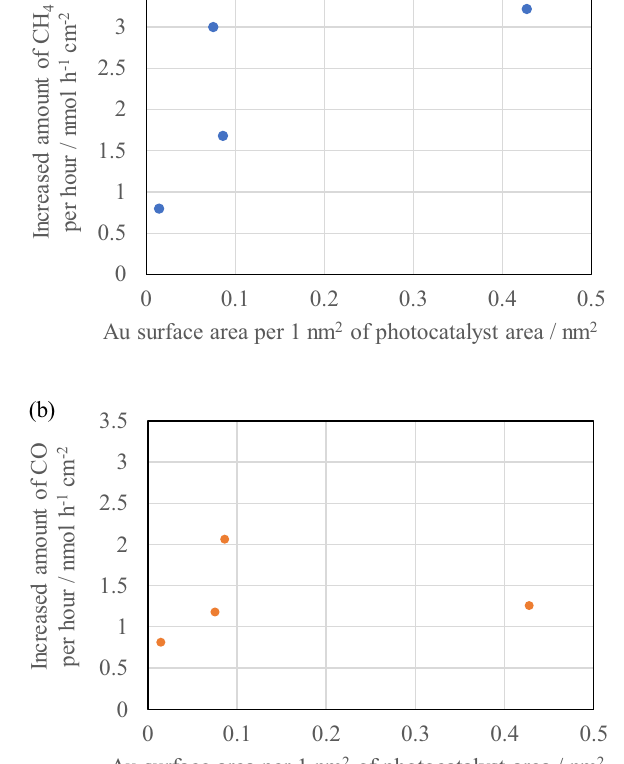
and b CO produced per 4